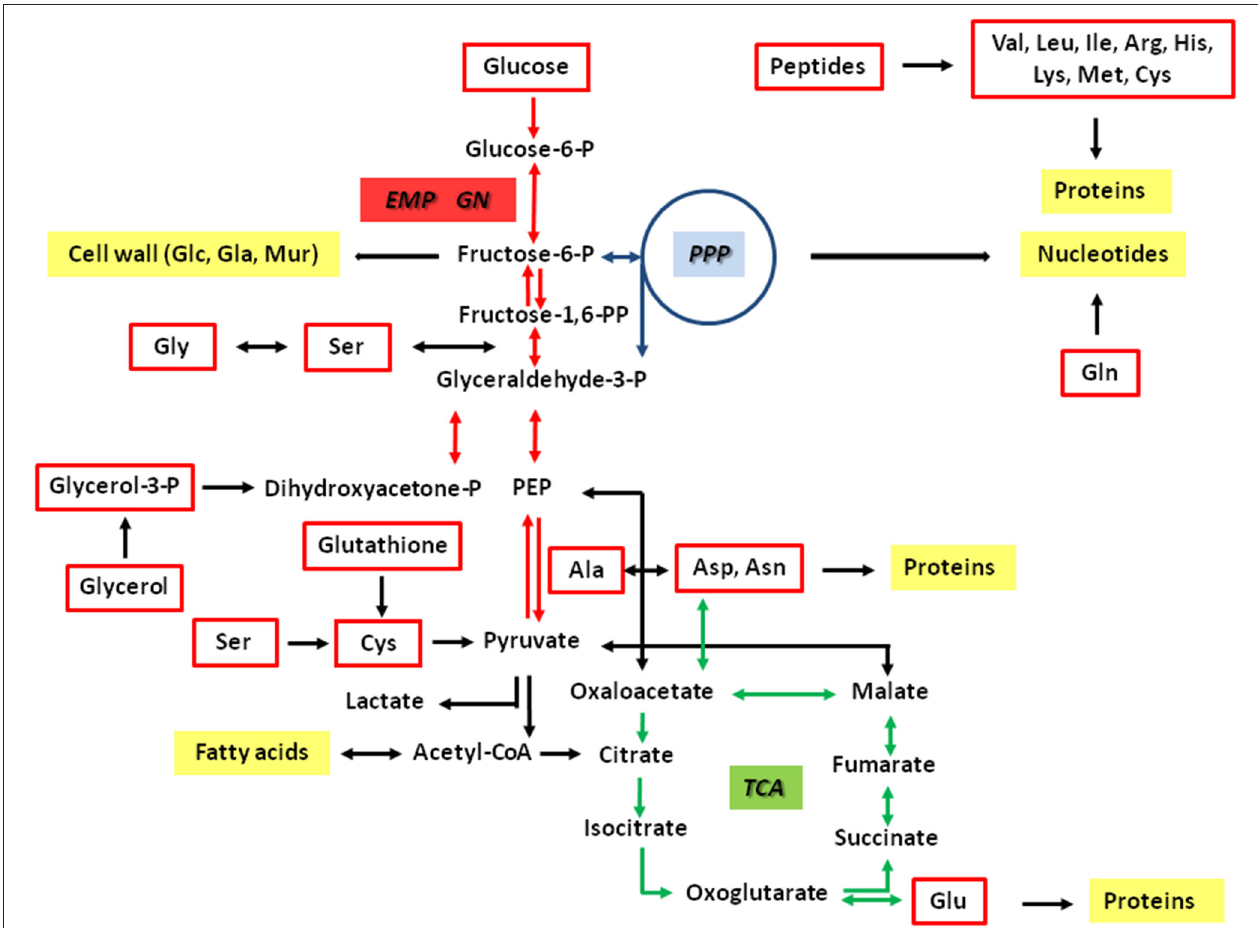
FIGURE 1 | Hypothetical metabolic network of Francisella tularensis . The pathways are predicted on the basis of the genome sequences and earlier biochemical studies ( Gyuranecz et al., 2010; Meibom and Charbit, 2010; Raghunathan et al., 2010; Barel et al., 2015). Potential carbon substrates are indicated by red boxes. Major metabolic products are indicated by yellow boxes. Reactions of the glycolytic pathway (EMP) and gluconeogensis (GN) are indicated by red arrows. Reactions of the pentose phosphate pathway (PPP) and the citrate cycle (TCA) are indicated by blue and green arrows, respectively. The interconnection between Gly and Ser includes the glycine cleavage